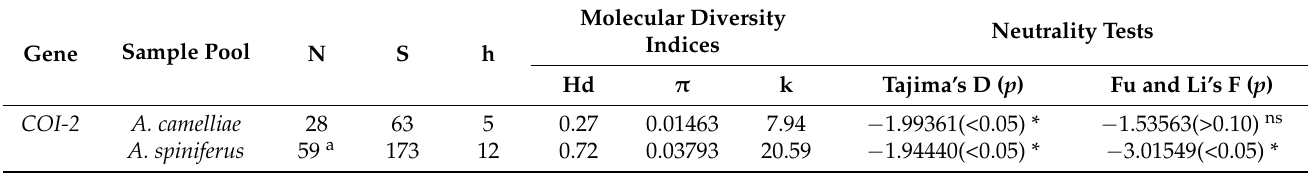
Table 2. Haplotype diversity of the Aleurocanthus spiniferus species complex was estimated from 450 bp COI-2 sequences retrieved from the NCBI database. A. spiniferus species complex includes A. camelliae, A. spiniferus, and A. woglumi sequences.